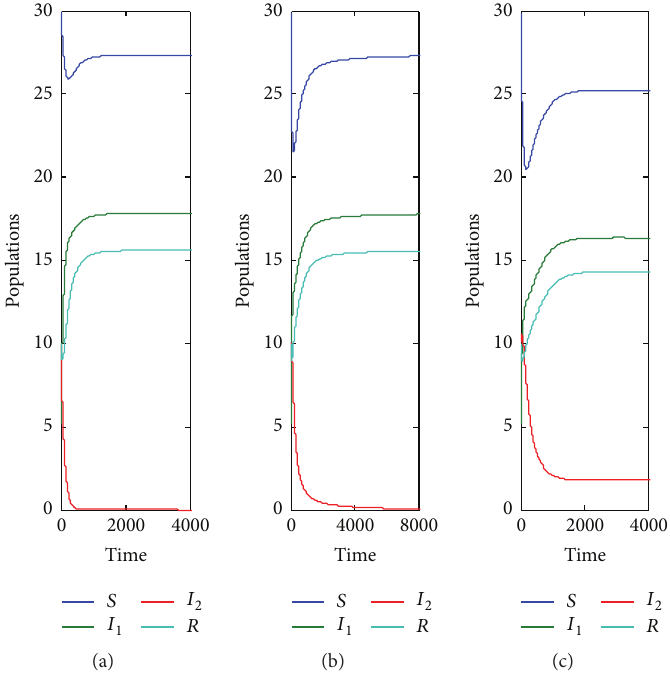
Figure 4: Time series of the solution of model (1) for the data given by (81). (a) For 𝛽 2 = 0.024 the model approaches to 𝐸 2 = = 0.059 the model approaches to the same point. (c) For 𝛽 (27.33, 17.80, 0,15.5) . (b) For 𝛽 2 (25.2, 16.3, 1.76, 14.3)